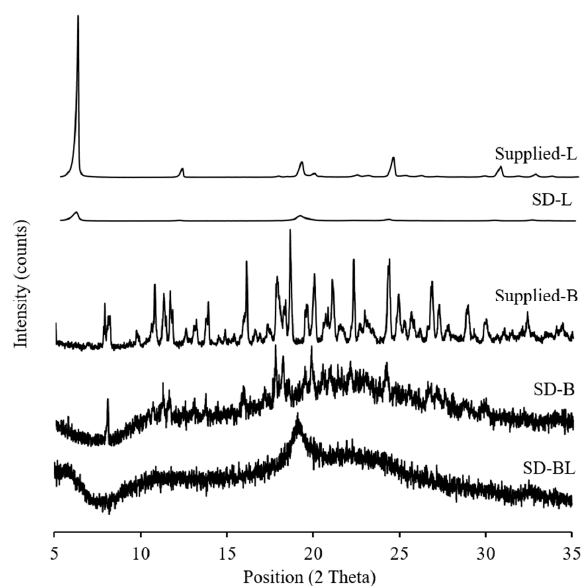
Figure 2. X-ray diffractograms of supplied materials and spray-dried powders (L and B mean L - leucine and bedaquiline; SD means spray-dried; BL means bedaquiline with 20% w/w of L -leucine).